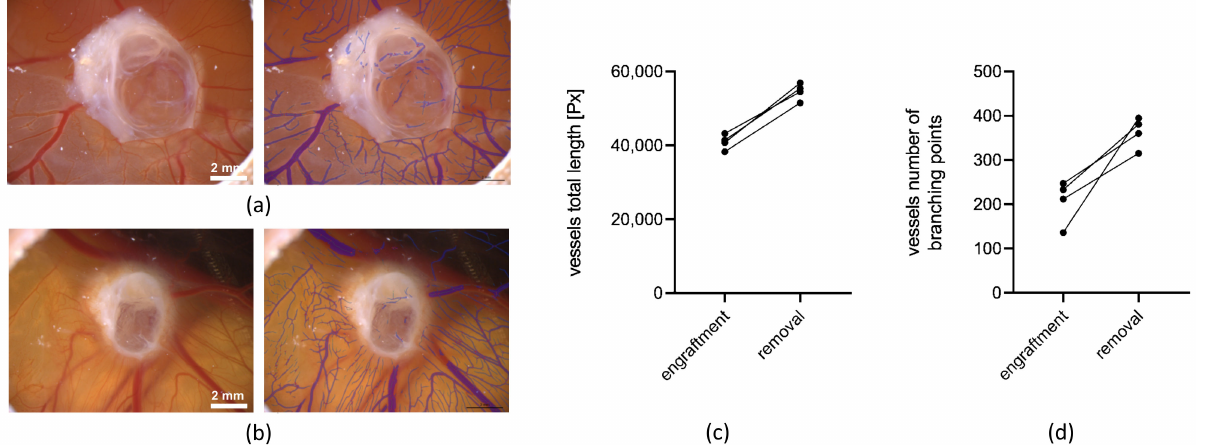
Figure 7. Analysis of the angiogenesis induced by renal cystic tissue on the CAM using the CAM assay application v3.0.0 and microscopic images taken with the Leica M205A microscope after the engraftment of the renal cystic tissue (( a ), left ) and prior to the removal (( b ), left ). Blood vessels which are marked blue in the microscopic images were recognized by the algorithm (( a , b ), right ). Analysis of the blood vessels of the CAM ( c ) showed an increase in the total vessel length during the experiments ( n = 4). Quantification of the number of branching points ( d ) showed an increase in vessel ramification after one week of growth on the CAM ( n =